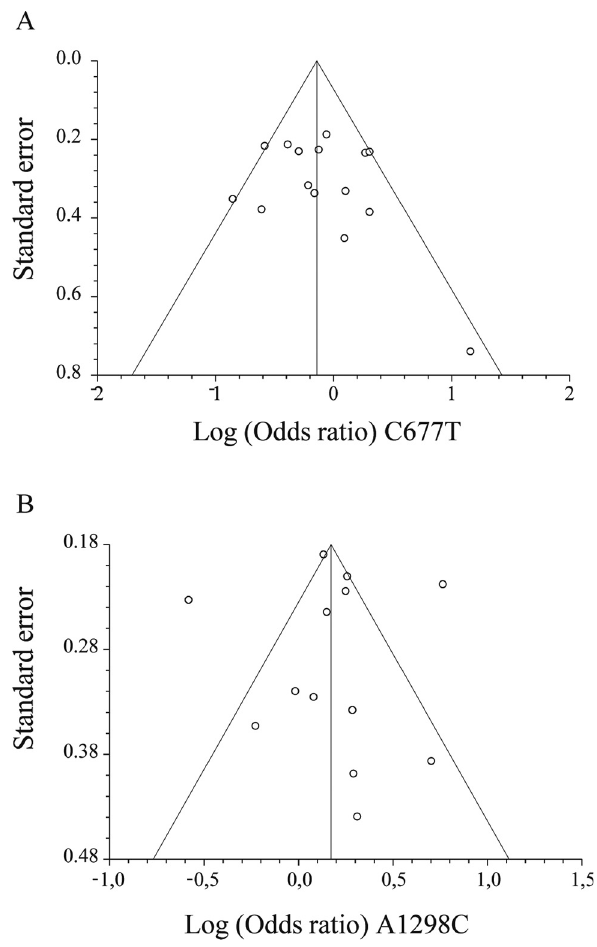
Figure 2 - Begg’s funnel plot for publication bias test. For the MTHFR C677T (A) and A1298C (B) polymorphisms, no detrimental asymmetry was observed (dominant model). Each point represents a separate study. Similar results were determined for all other genetic